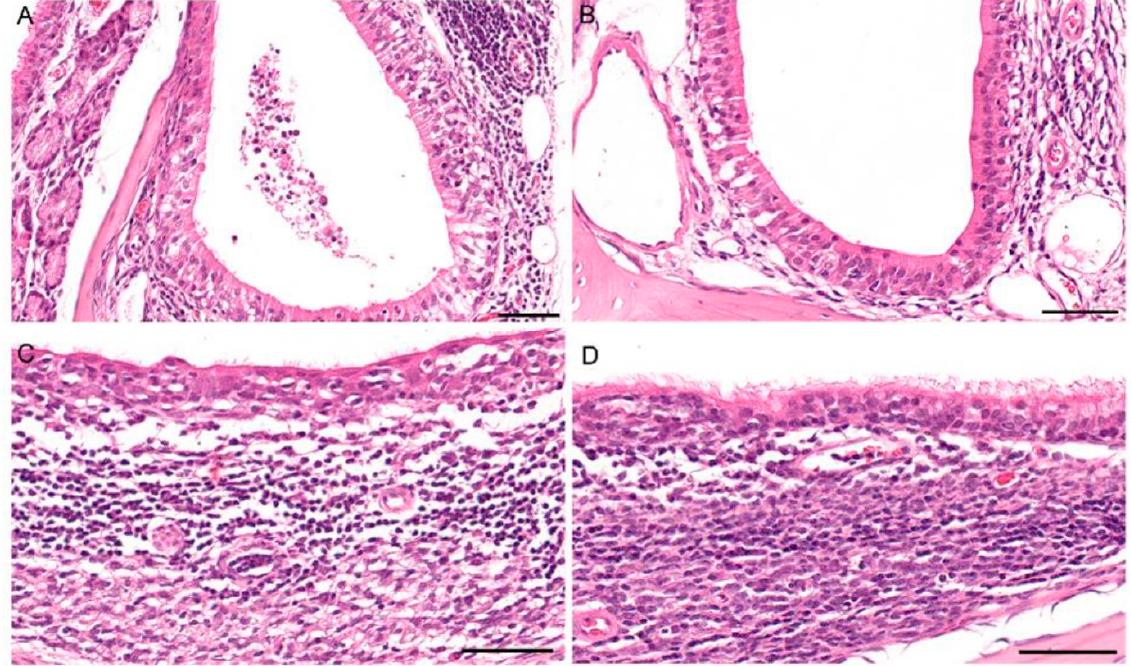
Figure 7. Histopathology in the nasal mucosa of fruit bats after infection with bat-origin H9N2 (A/bat/Egypt/381OP/2017), 7 dpi. ( A ) Inoculated animal #5: moderate transmigration of granulocytes and lymphocytes as well as intraluminal cellular debris within the nasolacrimal duct. ( B ) Unaffected nasolacrimal duct for comparison. ( C ) Contact animal #6: loss of cilia and moderate degeneration of the mucosal epithelium of the nasal-associated lymphoid tissue (NALT). ( D ) Unaffected NALT for comparison. All bars = 50 µm .